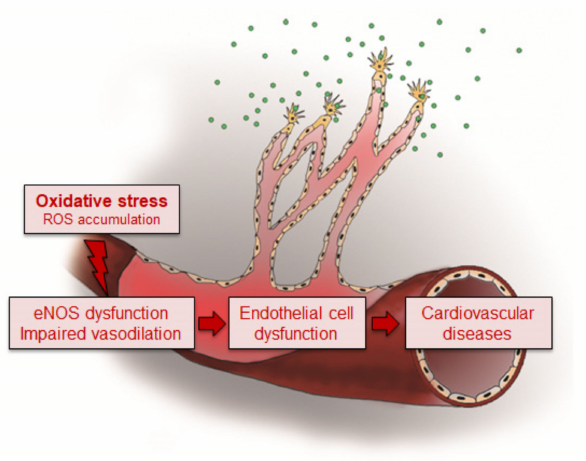
Figure 3. Oxidative stress induces the progression of cardiovascular diseases (CVDs). Oxidative stress plays a central role in the pathogenesis of CVDs. Excessive reactive oxygen species (ROS) causes damage to the cellular structure in the vascular wall and induces endothelial nitric oxide synthase (eNOS) dysfunction, leading to the impairment of vasodilation by the reduction in nitric oxide (NO) bioavailability. These changes contribute to the structural and functional alteration of the vasculature. The endothelial dysfunction is highly associated with the development of CVDs as an initial step in the process of